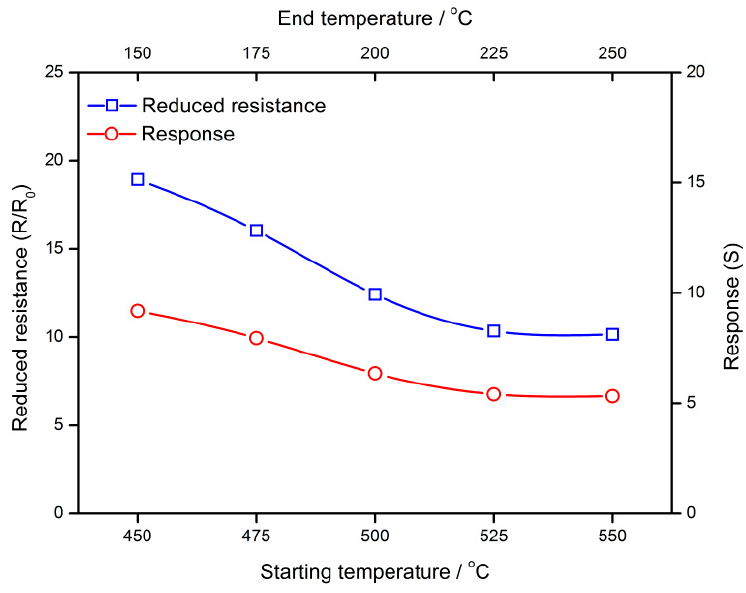
Figure 21. Influences of the temperature interval on gas-sensing characteristics of semiconductor gas sensors.